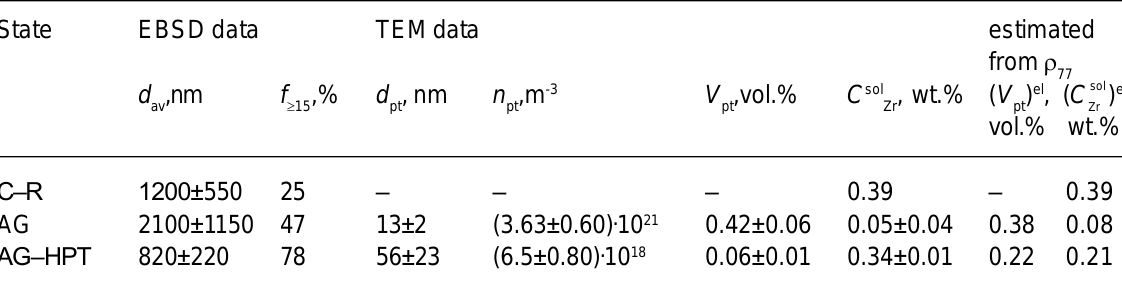
– average grain size, f – percentage of av  15 – concentration of second pt – concentration of solute Zr atoms. Zr